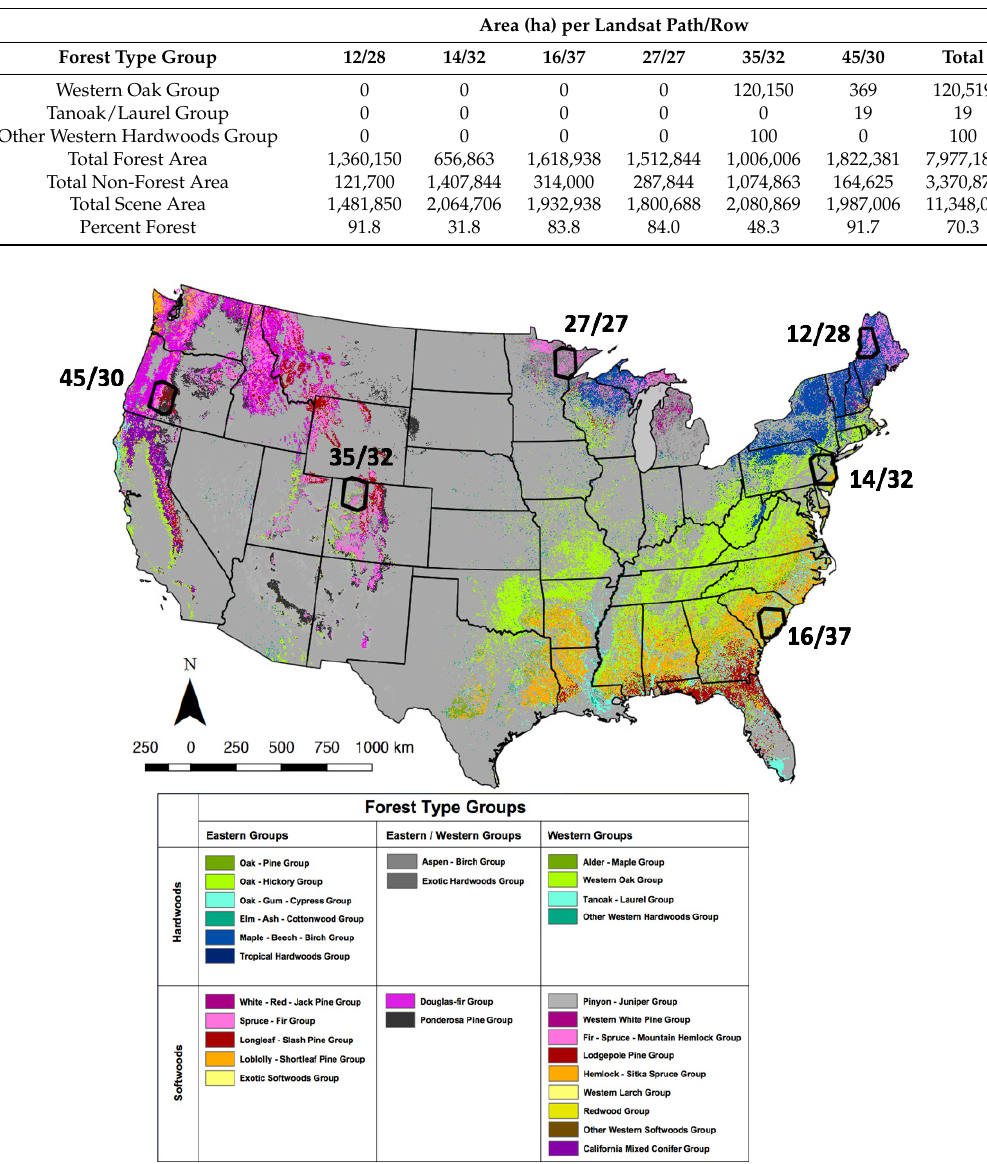
Figure 1. Locations within the United States of the six study scenes (WRS-2 Path/Row). Forest type groups used by the US Forest Service, Forest Inventory and Analysis program are displayed for context (adapted from [24]).